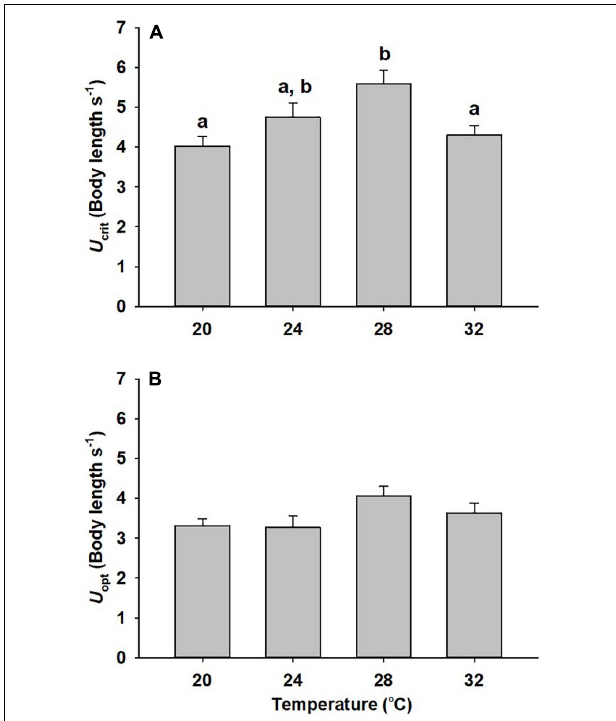
FIGURE 2 | Swimming performance of mahi acclimated to different temperatures. Critical swimming speed ( U crit ) (A) and optimal swimming speed ( U opt ) (B) of mahi exposed to 20, 24, 28, or 32 ◦ C ( U crit n = 16, 14, 14, 13, and U opt n = 12, 12, 12, 9, respectively). Different lowercase letters denote statistical significance ( p < 0.05) between temperatures performed using post hoc pair-wise comparisons. Figures with no letters mean that the initial comparison was not significant. Values represent means ± SEM.